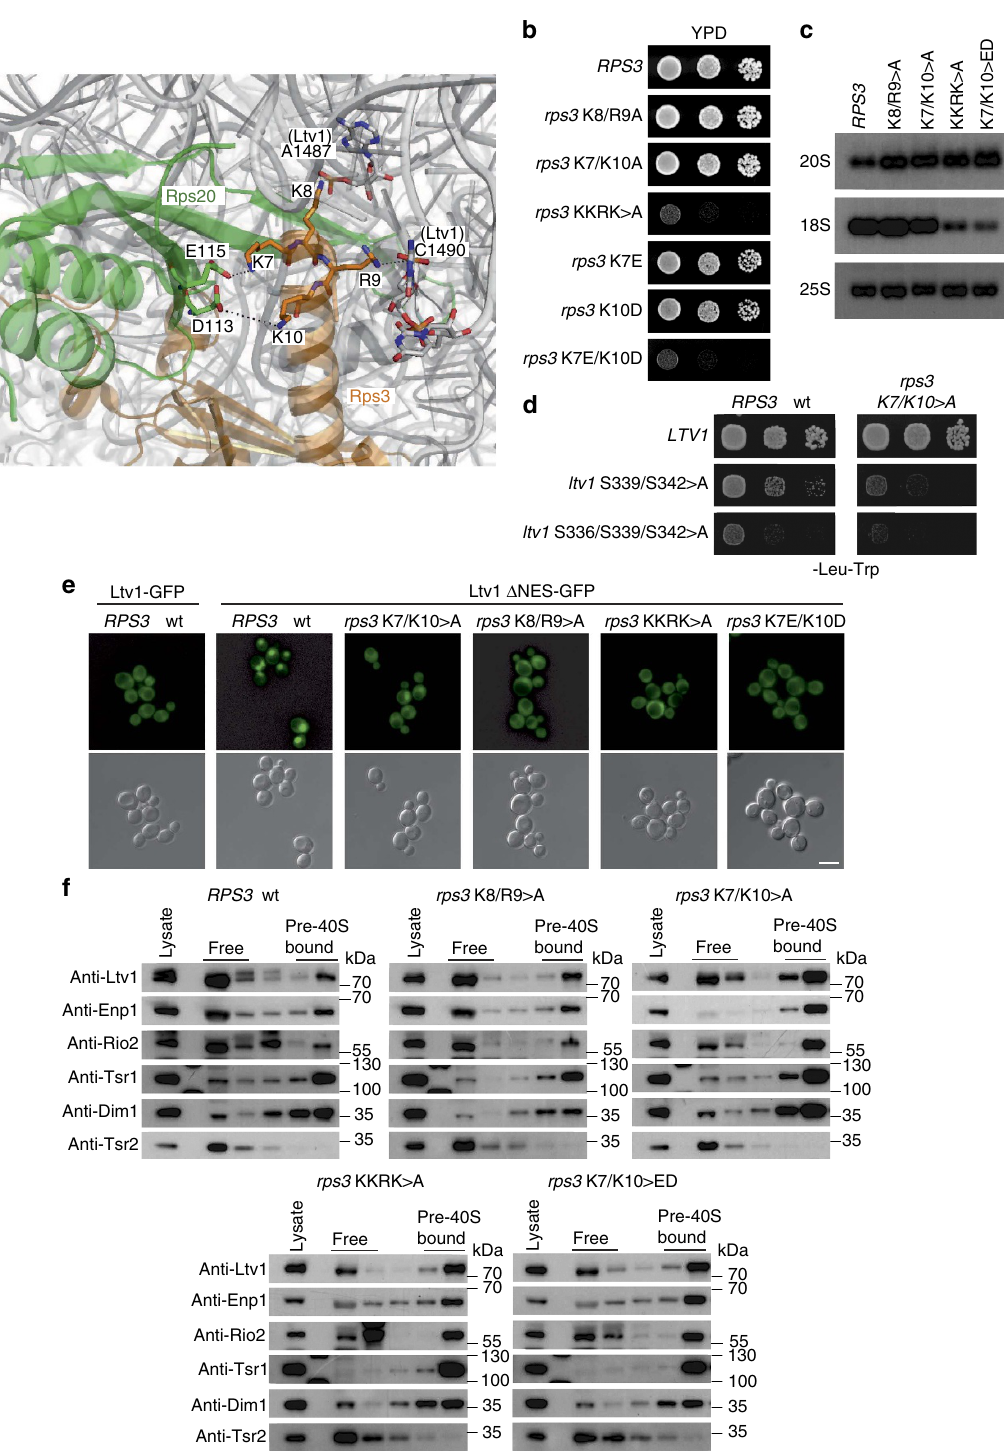
Figure 5 | Assembly of the Rps3 N-domain releases Ltv1 from pre-40S particles and is required for final 40S maturation steps. ( a ) N-terminal Rps3 residues form ionic contacts with negatively charged Rps20 residues and with rRNA nucleotides A1487 and C1490 around the rRNA-binding site of Ltv1 in helix 41 (PDB 3U5B and 3U5C). ( b ) Residues of the Rps3 N-domain interacting with Rps20 and rRNA are required for optimal cell growth. Growth phenotypes of the indicated rps3 alleles harbouring amino acid substitutions within the N-terminal residues K7, K8, R9 and K10 were examined after incubation at 23 (cid:2) C for 3 days (d). ( c ) N-terminal rps3 mutants display 20S pre-rRNA processing defects. The amounts of immature 20S and mature 18S rRNA in the indicated rps3 mutants were analysed by northern blotting. ( d ) rps3 (K7A/K10A) has a synthetically enhanced growth phenotype with ltv1 -phosphorylation mutants. The genetic interaction between the indicated alleles was examined after incubation at 23 (cid:2) C for 4 d. ( e ) The localization of Ltv1 D NES-GFP was examined in cells expressing the indicated rps3 alleles. Note that, in contrast to wild-type Ltv1-GFP, Ltv1 D NES-GFP displays a strictly nuclear localization in RPS3 cells that is shifted to the cytoplasm in the rps3 mutants. Scale bar, 5 m m. ( f ) rps3 mutants accumulate Ltv1 and further cytoplasmic assembly factors on pre-40S particles. Lysates of the indicated rps3 mutants were analysed by 7–45% sucrose gradient centrifugation, and the upper fractions of the gradients containing soluble proteins (free) to 40S subunits (pre-40S bound) were analysed by western blotting with the indicated antibodies. NATURE COMMUNICATIONS|7:10336|DOI: